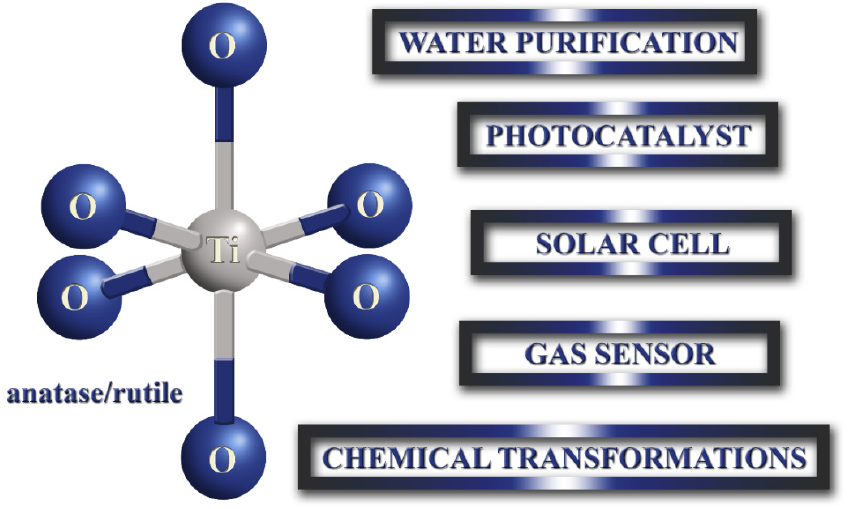
Figure 1. The range of possible applications of titanium dioxide in modern